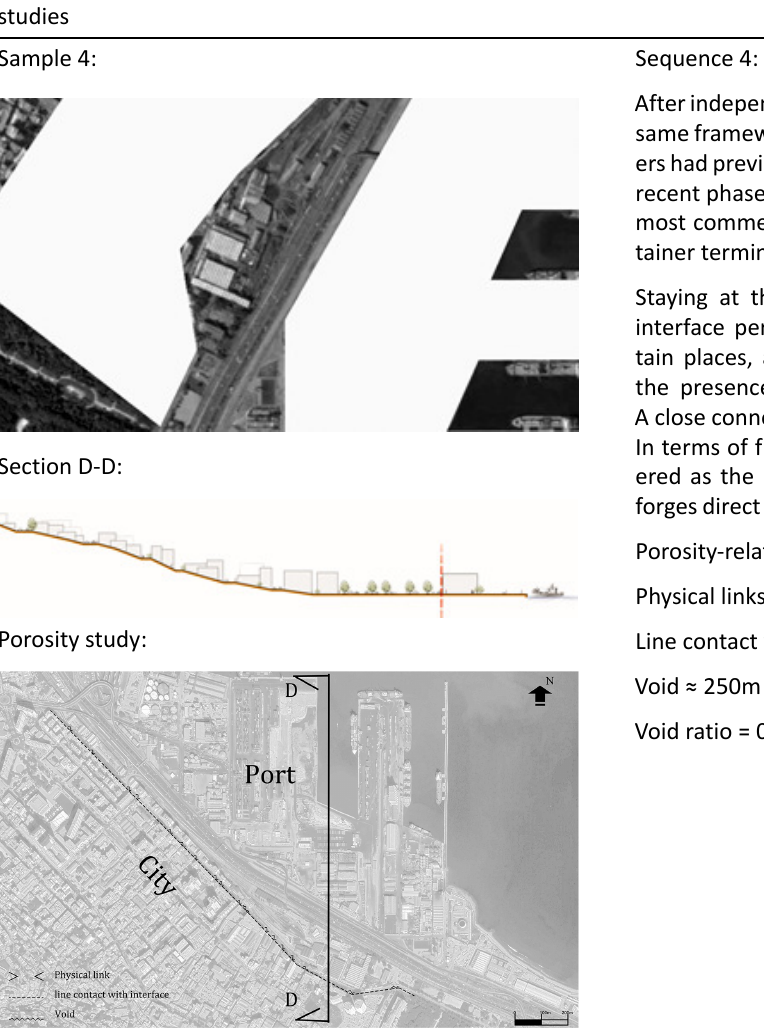
Table 1. (Cont.) Different sequences of Algiers’ current port‐city interface. Satellite views with schematic cross‐sections and